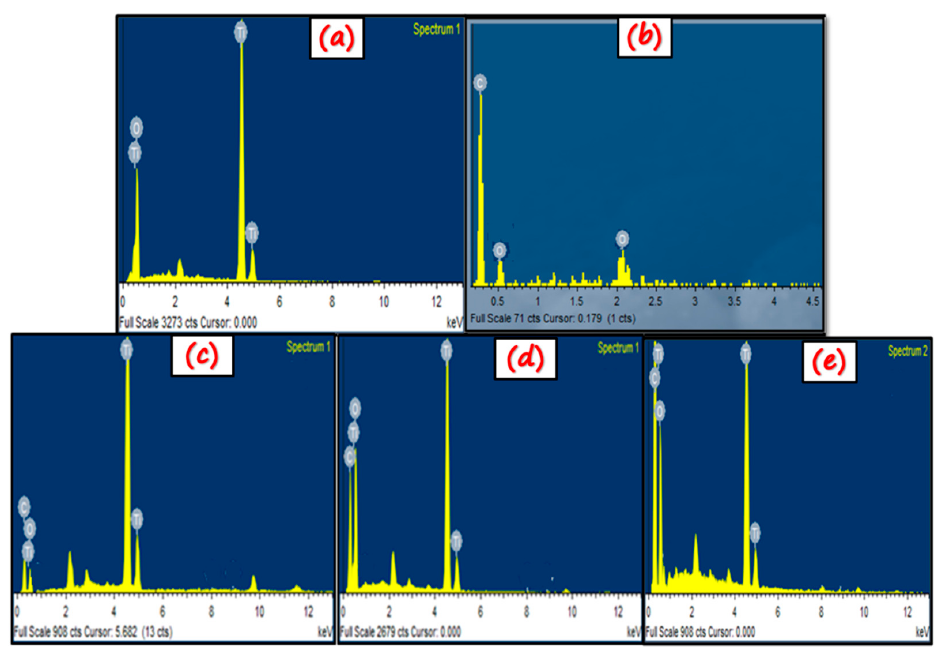
Figure 5. EDX spectra of ( a ) TiO 2 , ( b ) GO, ( c ) NC-1, ( d ) NC-2, and ( e ) NC-3.